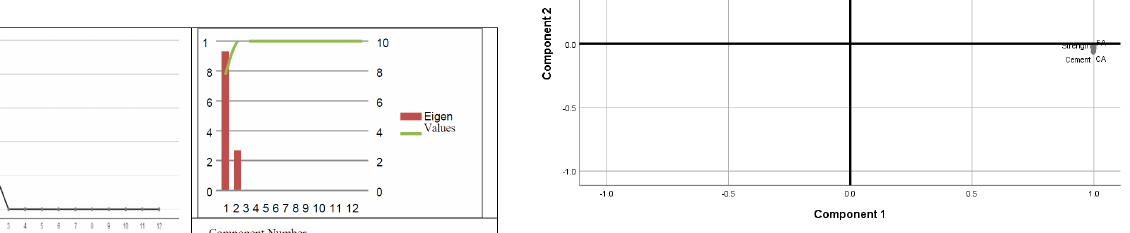
Figure 2: Variation of Parameters Vs